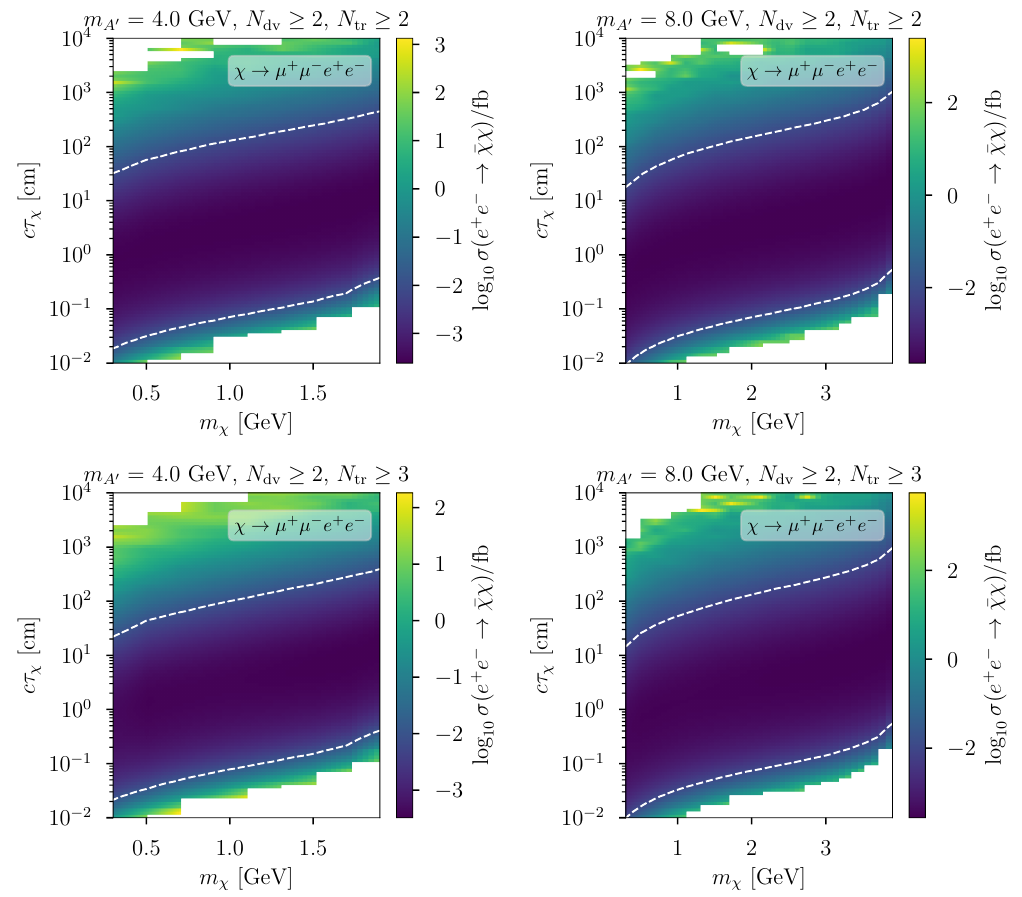
Figure 4 . Cross-section sensitivity in fb of Belle II based on 10 signal events in a 50 ab − 1 dataset for scalar LLPs χ decaying to e + e − µ + µ − and the dark photon production mode. The upper (lower) row shows the result of demanding at least 2 (3) charged tracks from two displaced vertices. The left (right) column fixes m = 4 ( 8 ) GeV. The white dashed contours correspond to a production A 0 cross section of 10 − 2 fb , which is roughly equivalent to ε ∼ 10 − 5 for m 8 GeV . A 0 ≤ hadronization to produce extra tracks. The acceptance for this search is greatly reduced at low m because the dominant χ decays have two tracks in this mass range. As before, χ the acceptance of N ≥ 2 events is roughly the square of the N ≥ 1 dv dv